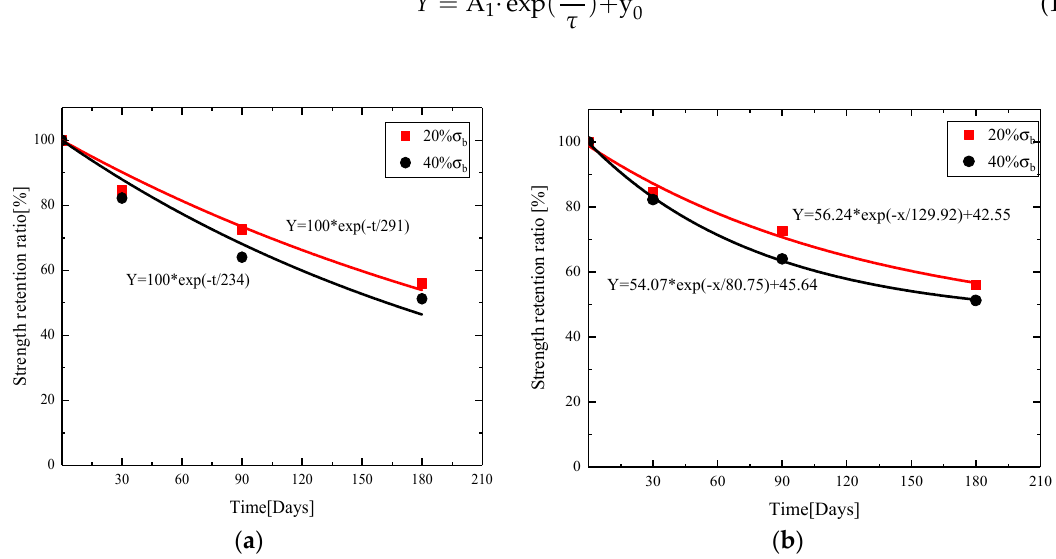
Figure 7. Fitting curve of strength retention ratio of GFRP bars in alkaline solution under different loading of: ( a ) classical model; and ( b ) modified model.